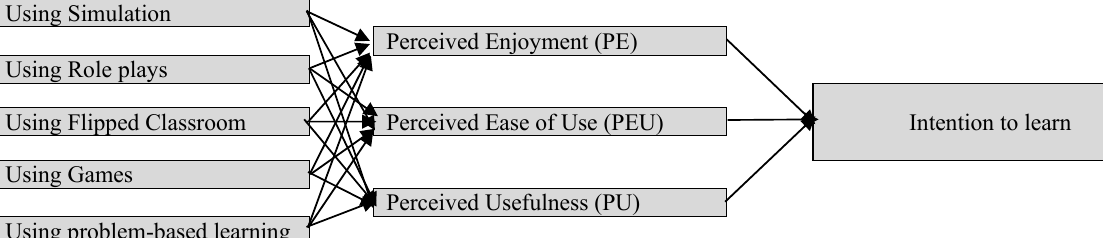
Fig. 1. Research Conceptual